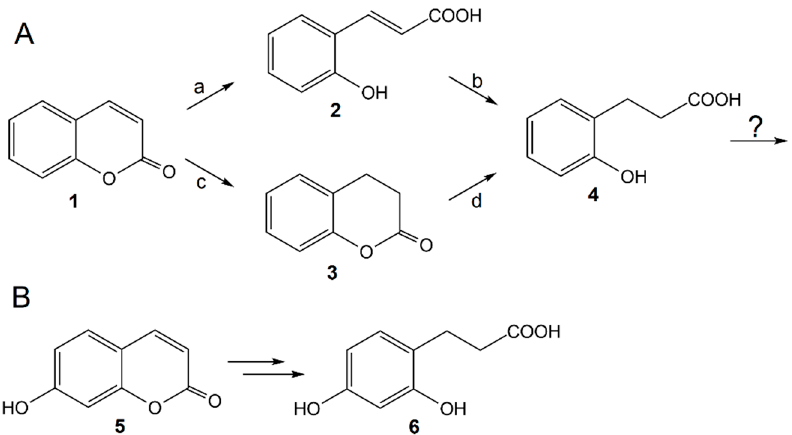
Figure 1. ( A ) Coumarin metabolic routes in Arthrobacter spp. (a, b), as well as Pseudomonas and Aspergillus spp. (c, d). ( B ) Proposed metabolic pathway of 7-hydroxycoumarin in Pseudomonas sp.